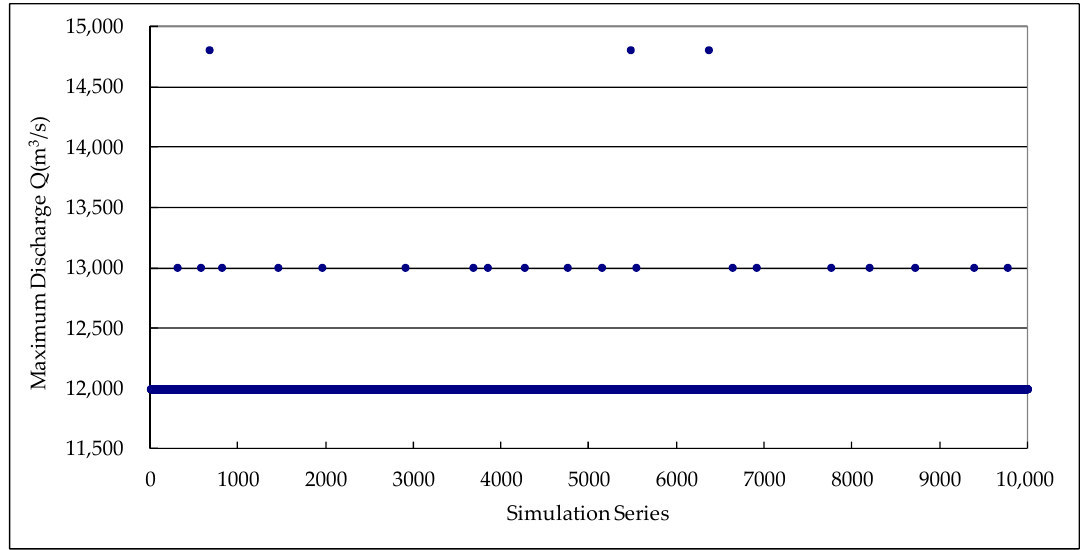
Figure 6. Maximum release in 10,000 simulations for five-year flood (P = 20%) based on FBO.